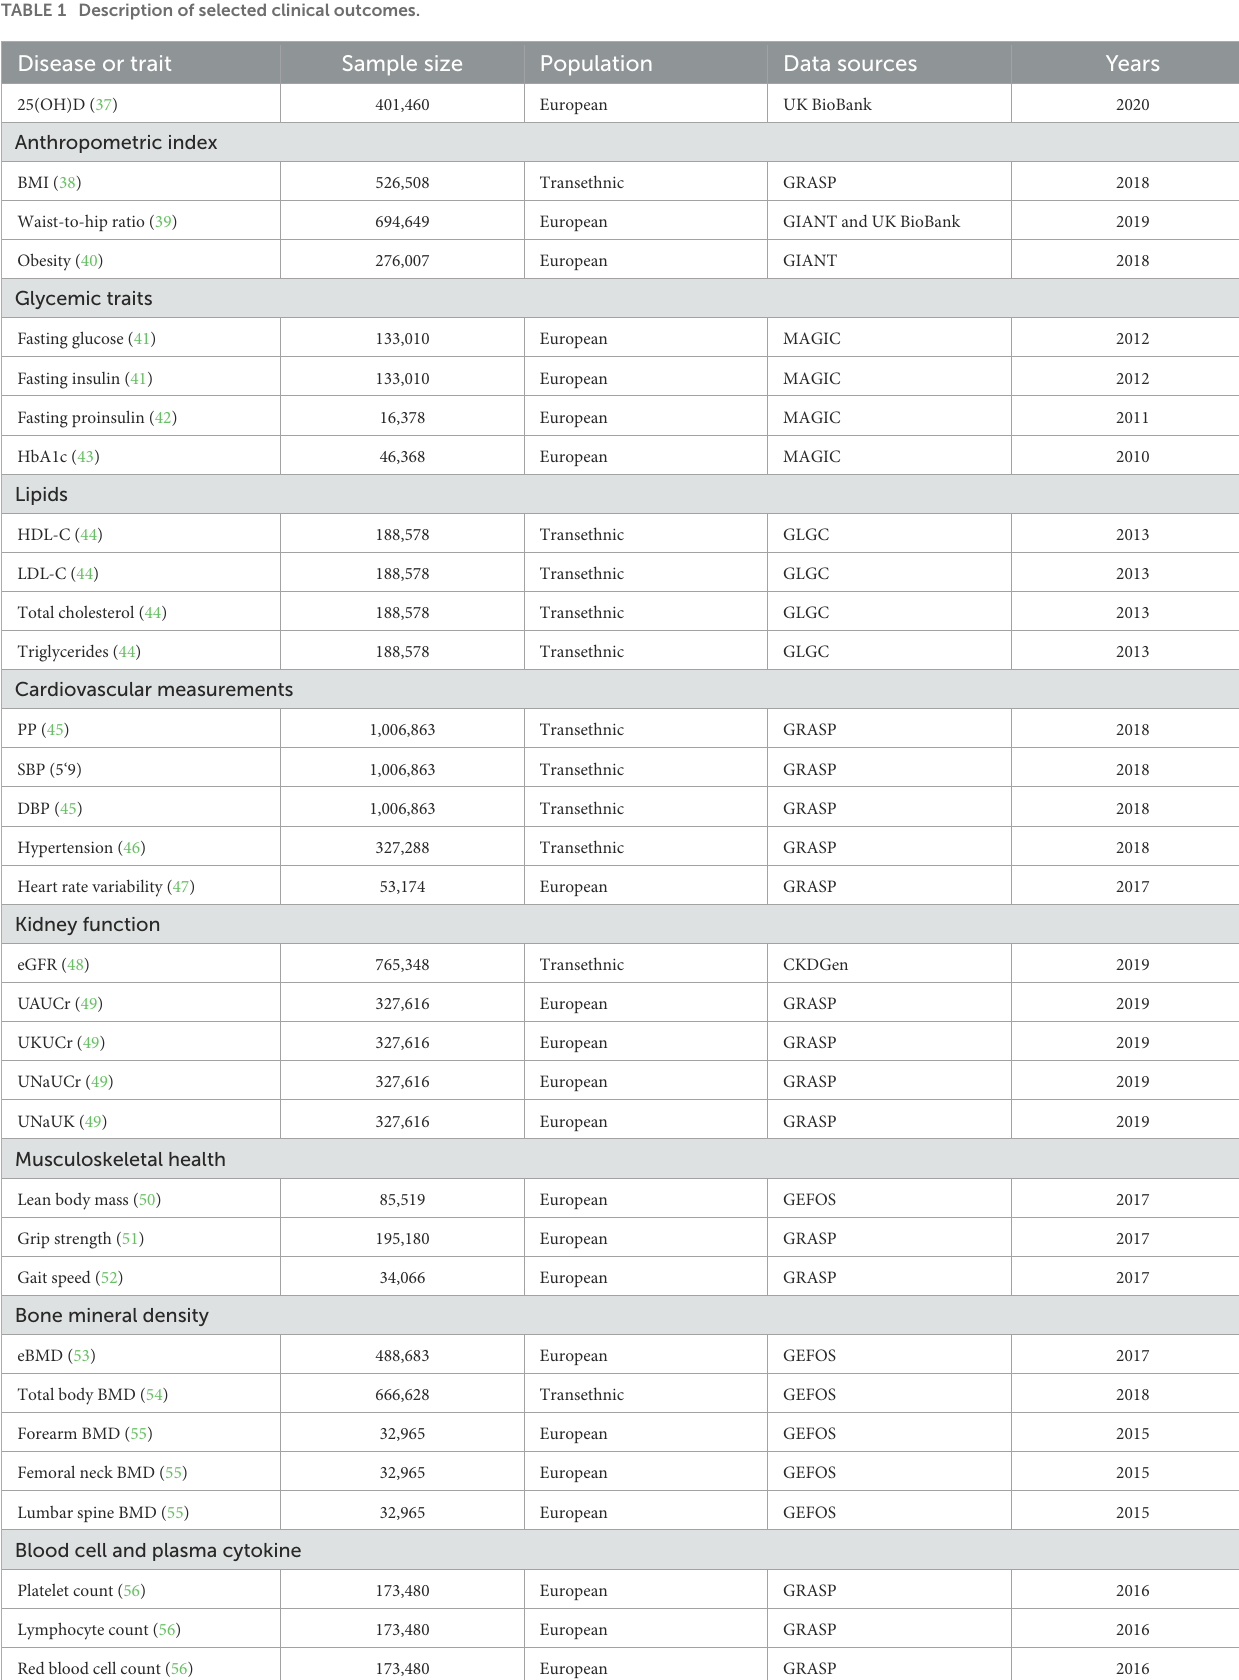
TABLE 1 Description of selected clinical